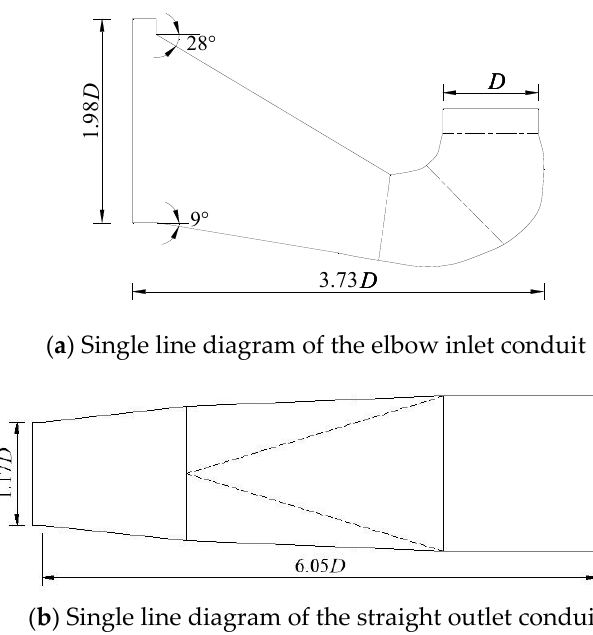
Figure 3. Single line diagram of the inlet and straight outlet conduit.